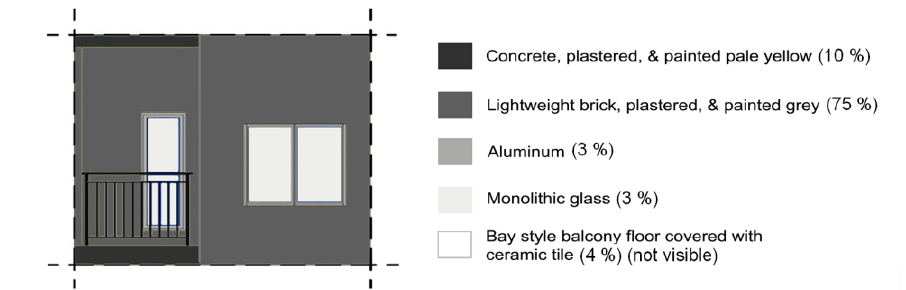
Fig. 5. Façade of apartment units with glass windows on plain wall and glass door in a small balcony (C